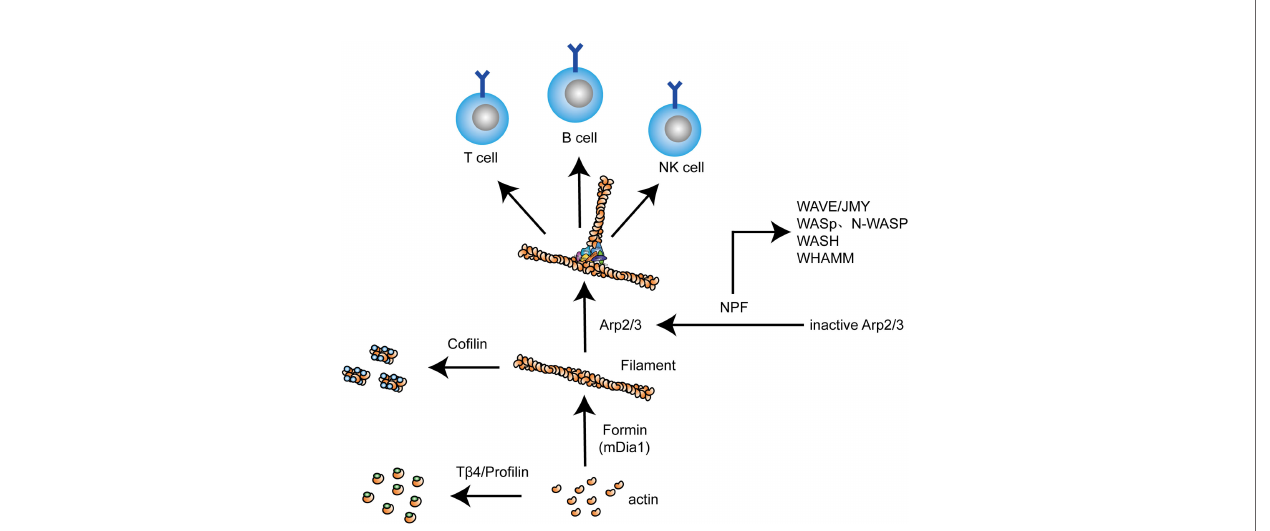
FIGURE 2 | Different actin regulators play distinct roles in actin dynamics in lymphocytes. As actin-monomer-binding proteins, pro fi lin and thymosin beta 4 (T b 4) bind G-actin and prevent it from polymerizing, while formins act in an opposite manner, promoting actin fi lament polymerization. The activation of Arp2/3 complex requires NPFs including WAVE, JMY, WASp/N-WASp, WASH, and WAHMM, which is needed for branching F-actin. The severing of F-actin is mediated by co fi lin. In the above process, actin undergoes dynamic changes in lymphocytes, thereby regulating cellular activity and